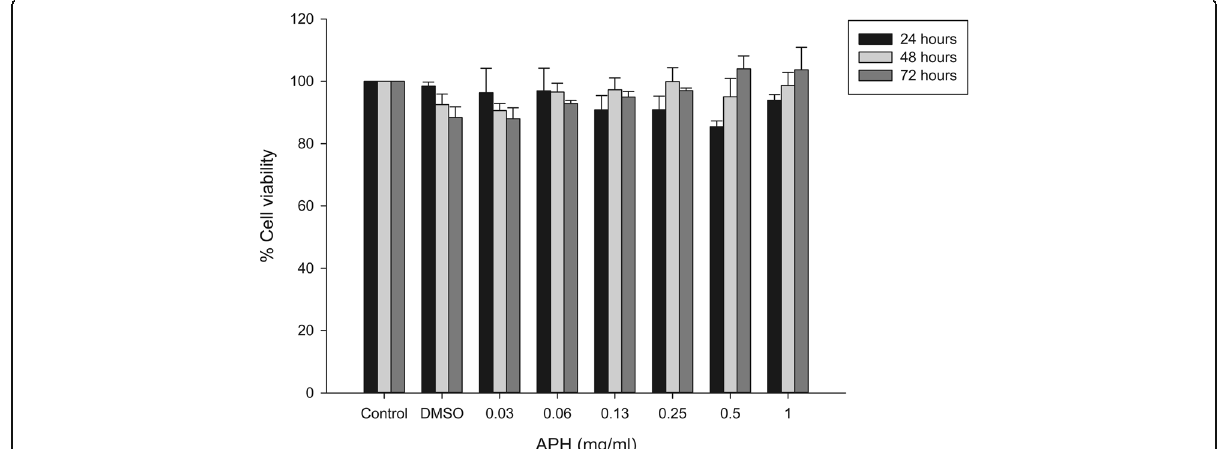
Fig. 2 Cytotoxicity of APH against 3 T3-L1 cells at 24, 48 and 72 h. The error bars indicate the standard error of the means. * p < 0.05 compared to vehicle